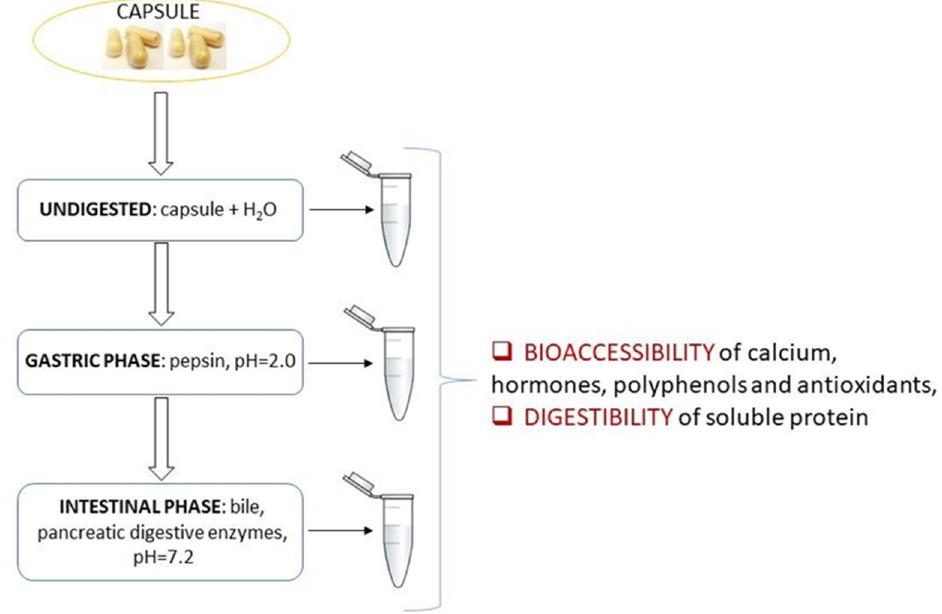
Figure 1. Diagram of the in vitro digestion performed. Table 4. Comparison of the bioaccessibility of protein, calcium, testosterone, estradiol, polyphe- nolic compounds, and antioxidants in the tested fractions.